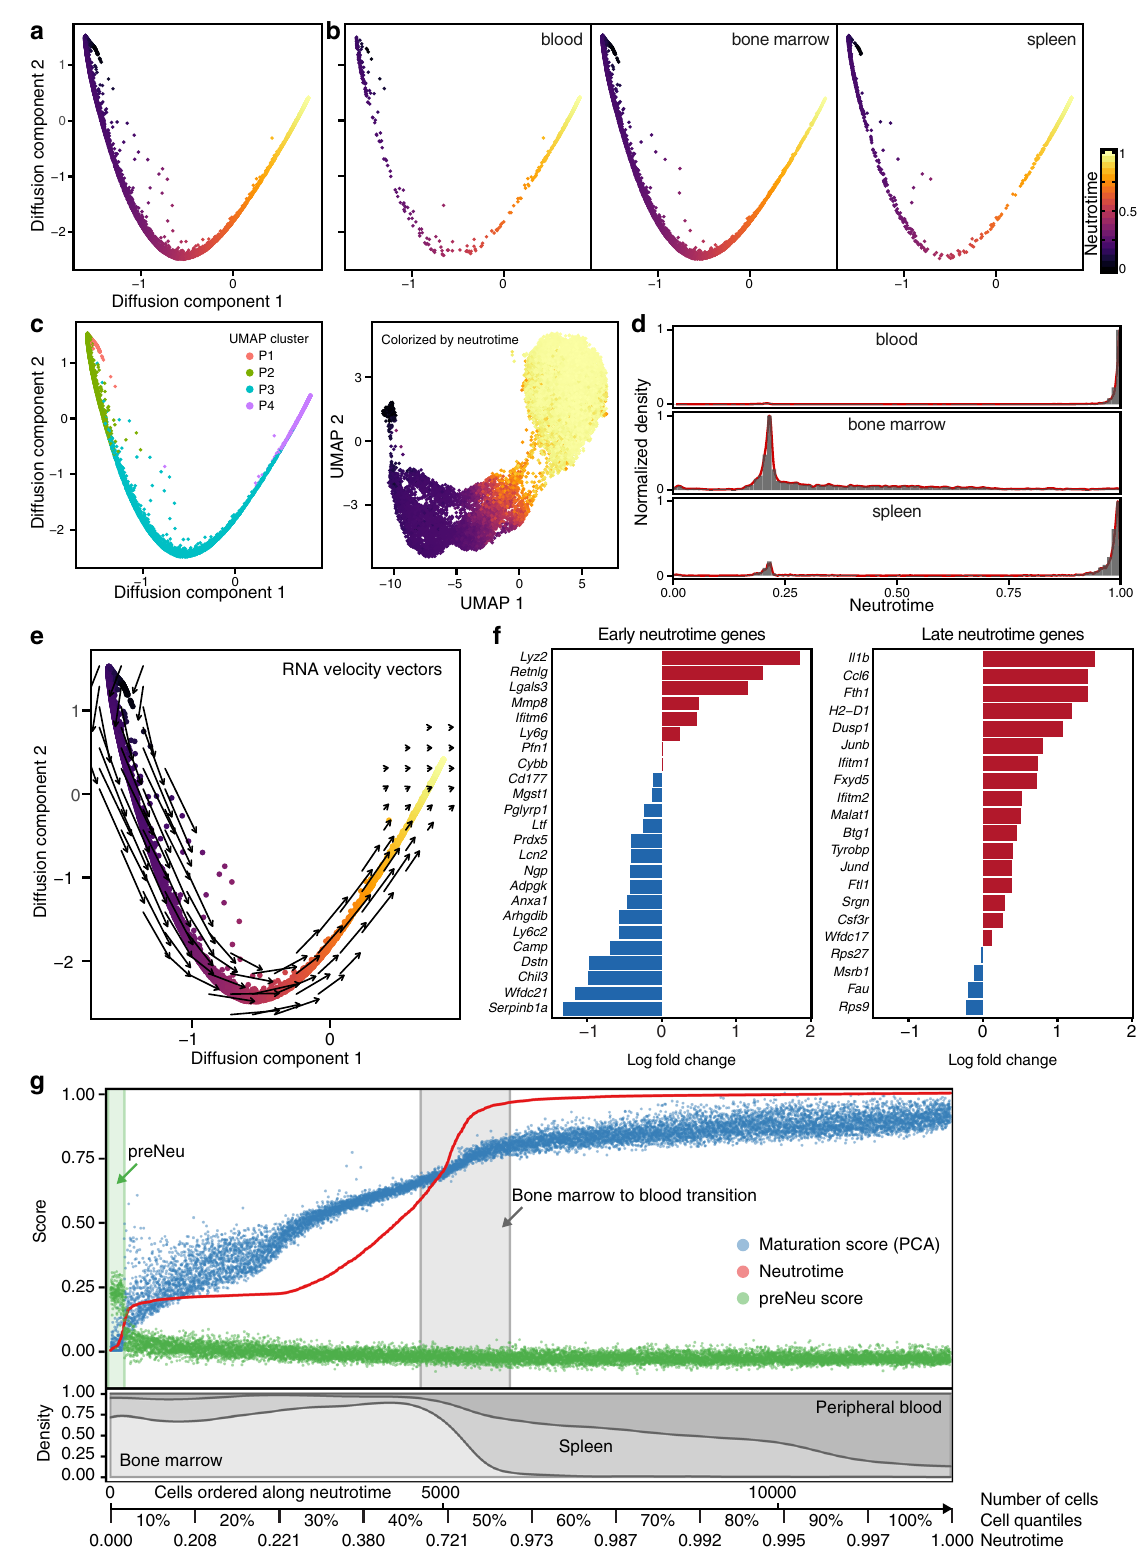
featuring de novo expression of a distinct gene set. Not all genes changed in a uniform direction over neutrotime; some, such as Retnlg encoding Resistin-like gamma precursor, Mmp8 and Mmp9 encoding the Matrix metalloproteinases 8 and 9, and Mcemp1 encoding Mast Cell Expressed Membrane Protein 1, peaked between the poles of neutrotime (Fig. 3c). We